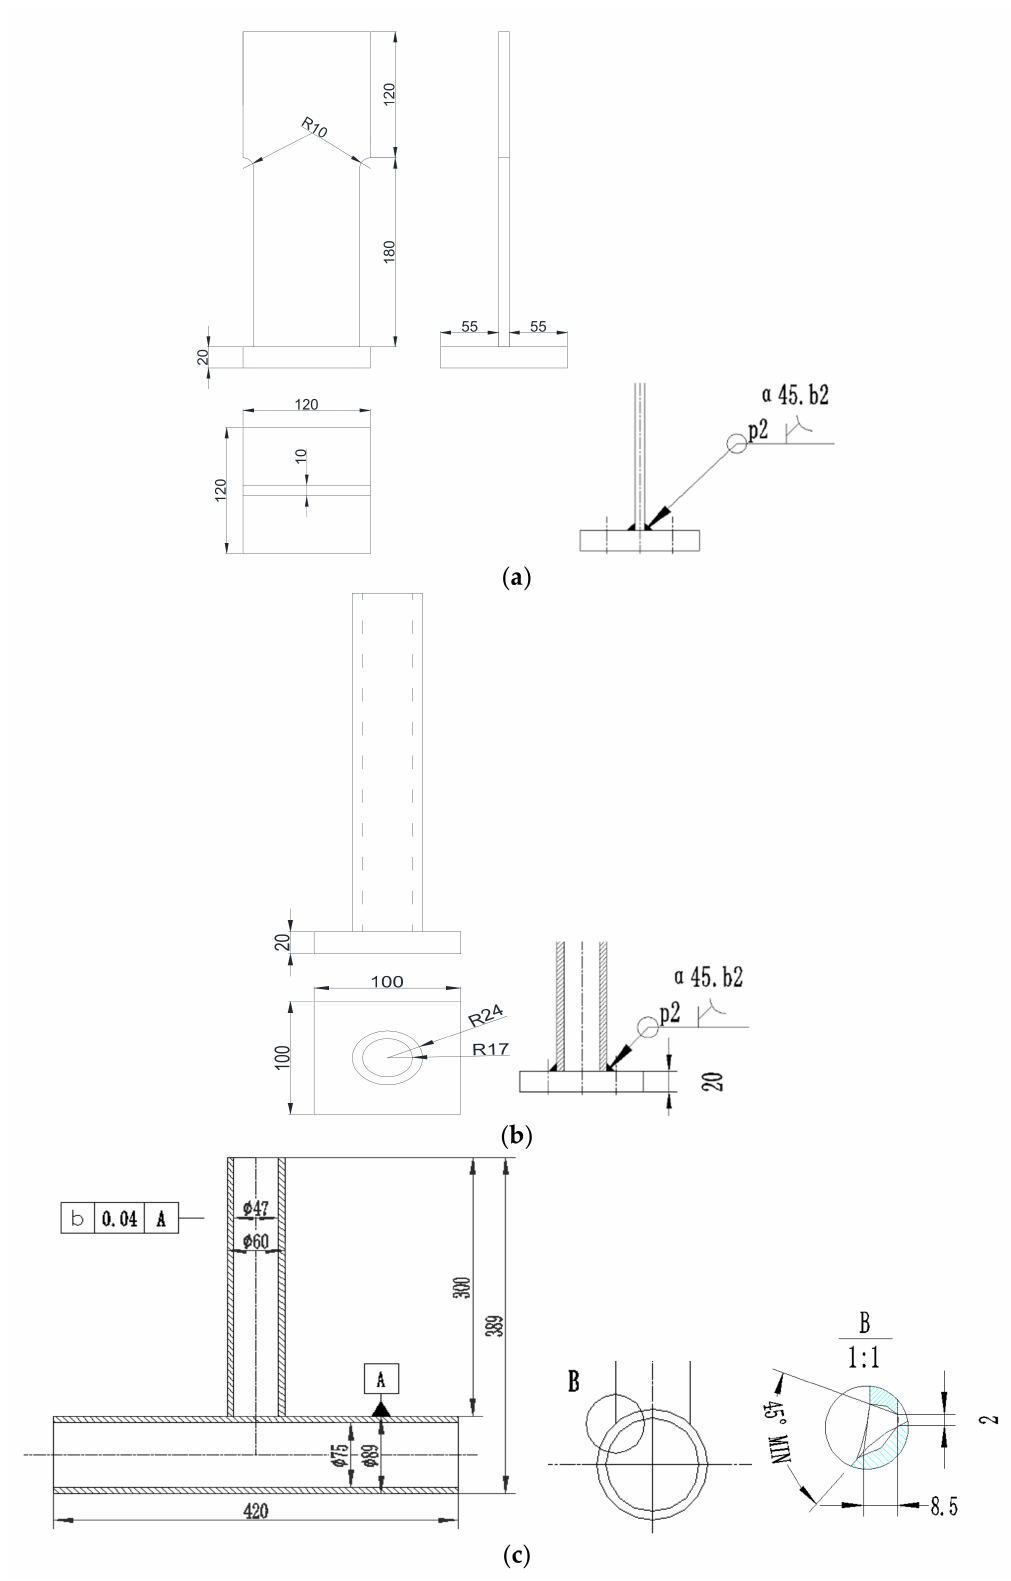
Figure 2. Geometry of the three types of specimens used in laboratory measurements. ( a ) T-type plate joint. ( b ) T-type tube-plate joint. ( c ) T-type tube